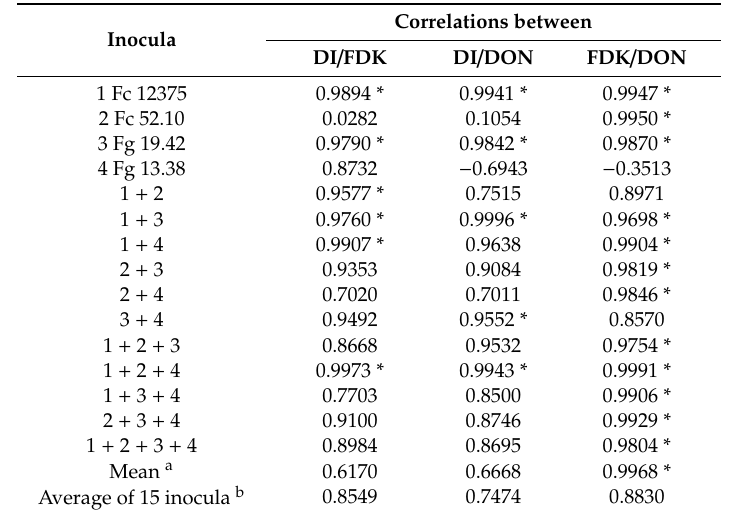
Figure 6. Correlations between genotype reactions to different FHB traits (data from figures 2–4, for each isolate the performance of the cultivars was related to the mean of genotypes). Limit for p = 0.05 = 0.51, p = 0.02 = 0.59, p = 0.001 = 0.77. Table 10. Correlations between DI, FDK and DON contamination the four cultivars ( n = 4) for each isolates and mixtures and their means, Szeged, 2013–2015.